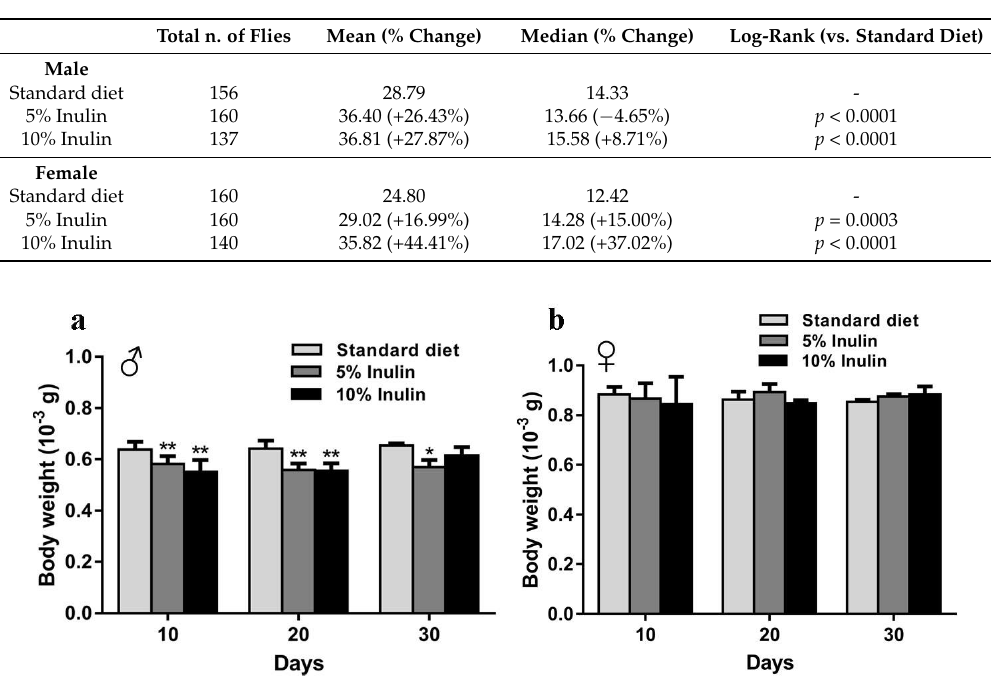
Figure 3. Body weight of InR p5545 /TM3 D. melanogaster fed an inulin-supplemented diet or a standard diet in male ( a ) and female ( b ) flies. Error bars indicate standard errors. p values were calculated by comparing the inulin-fed flies to flies fed a nonsupplemented standard diet. * p ≤ 0.05; ** p <